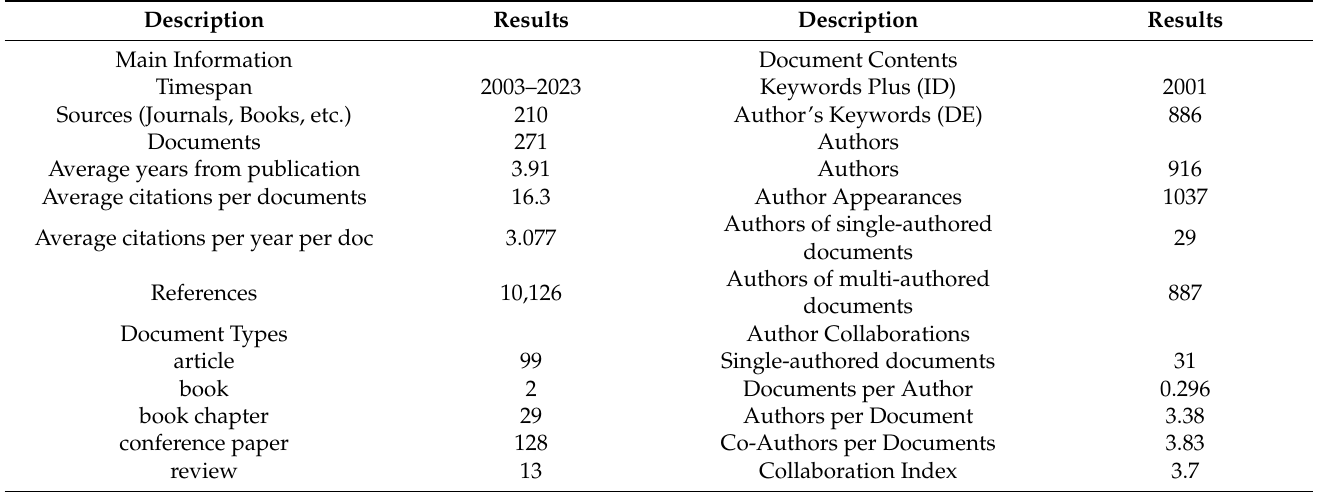
Table 2. The main information and statistics used in this study